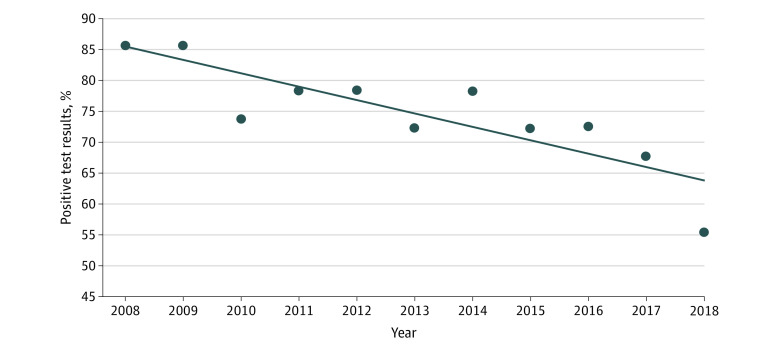
Documented Positive BRCA Test Results Among Women 65 Years of Age or Older, 2008-2018The diagonal line indicates the trend in documented positive BRCA test results.